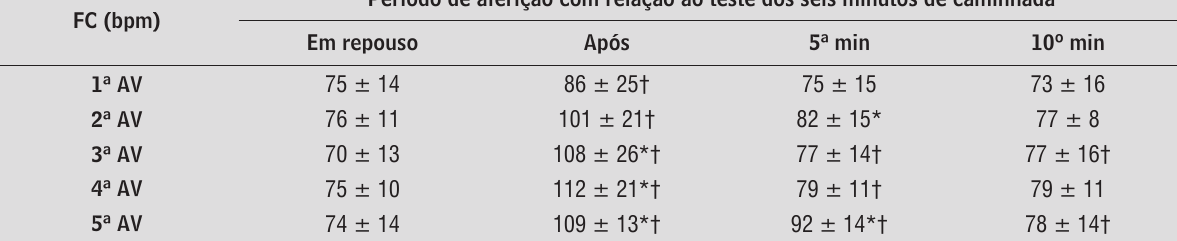
Tabela 3 - Frequência cardíaca (FC) dos sujeitos antes (Em repouso), imediatamente após (Após) e no quinto (5º min)